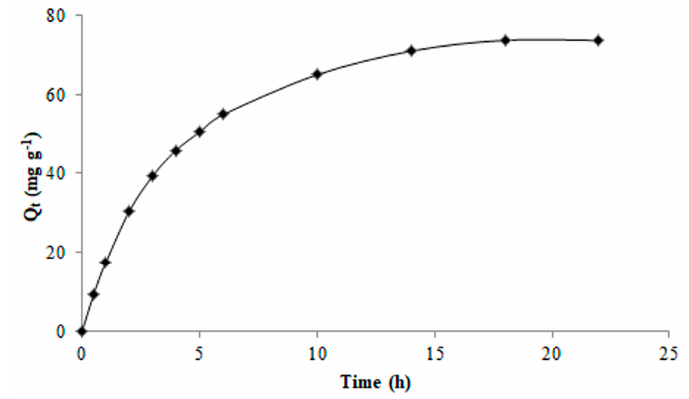
Figure 8. Adsorption kinetic curve of Pd-IAzoCsM.